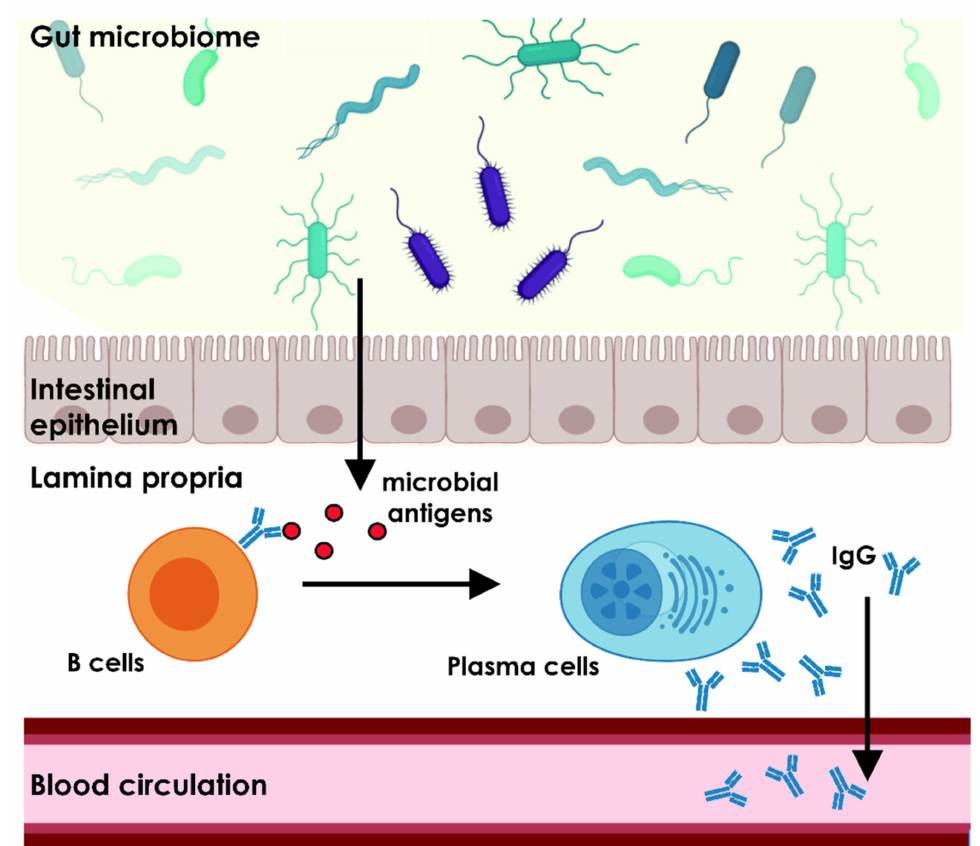
Figure 1. Putative influence of the commensal gut microbiome to systemic IgG-mediated immunity. Microbial antigens can pass through an impaired gut barrier, represented by the intestinal epithelium. The antigens bind to B cell receptors of B cells located in the lamina propria. Upon antigen recognition, the B cells differentiate into IgG secreting Plasma cells. The secreted immunoglobulins can enter the blood circulation or plasma cells directly translocate into blood vessels. Microbiota often exhibit highly conserved proteins with high sequence homology to the same proteins expressed in higher organisms including homo sapiens . This can lead to cross-reactivity of anti-microbial antibodies to self-antigens in the host organism via molecular mimicry. However, the gut microbiome has major influence on the diversity of the systemic antibody stock, regardless of their autoreactive